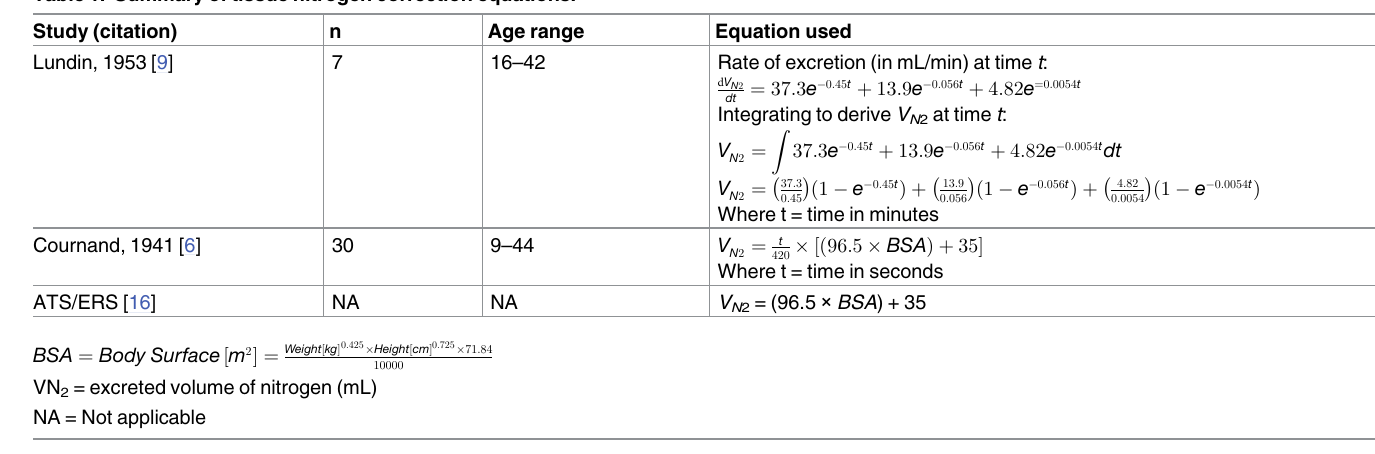
indicates the first breath of the washout phase, and final subscript indicates the first breath of the washout phase where (Cet - Cet ) is less than the target threshold. N2 N2 BT Three different equations (Table 1, Fig 1) were used to derive (V ). Cournand’s body N2 BT size-dependent Eq (6) and Lundin’s three-phase exponential excretion rate Eq (14) are time- dependent and calculate the end tidal tissue N concentration (Cet ). The ATS/ERS (22) 2 N2 BT equation is time-independent and is therefore only used to generate V and not Cet . N2 BT N2 BT Therefore, corrected FRC values were generated from all three equations (with Cet N2, final being uncorrected in the ATS/ERS equation), but corrected LCI values were only generated from the time-dependent equations. To assess whether the breath-by-breath calculated FRC achieves a plateau, linear regression slopes of the FRC /time curves were calculated for the second half all uncorrected and cor- N2 rected washouts.